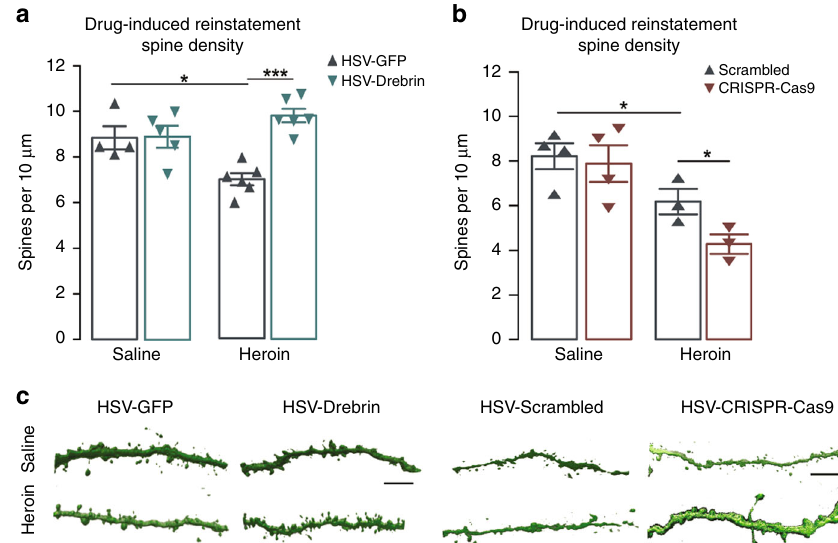
Fig. 3 Drebrin in the NAc regulates opiate-induced structural plasticity. a Spine densities on MSNs in the NAc following intra-NAc HSV-drebrin expression (two-way ANOVA: drug effect, F 2,15 = 0.482, P < 0.05; virus effect, F 1,15 = 13.71, P > 0.05; interaction, F 2,15 = 5.91, P < 0.01, saline-GFP vs heroin-GFP, P = 0.008; heroin-GFP vs heroin-drebrin, P = 0.0002; saline-GFP vs heroin-drebrin, P = 0.125; n = 5 – 6 per group). b Spine de n sities on MSNs in the NAc following intra-NAc CRISPR-Cas9 drebrin (two-way ANOVA: drug effect, F 1,10 = 20.92, P < 0.001; virus effect, F 1,10 = 3.858, P > 0.05; interaction, F 1,10 = 2.138, P > 0.05; saline-scrambled vs heroin-scrambled, P = 0.05; heroin-scrambled vs heroin-CRISPR, P = 0.04; n = 3 – 4 per group). c Representative images of virus-infected neurons; scale bars, 5 μ m. Data are expressed as means ± SEMs. * P < 0.05, *** P < 0.001